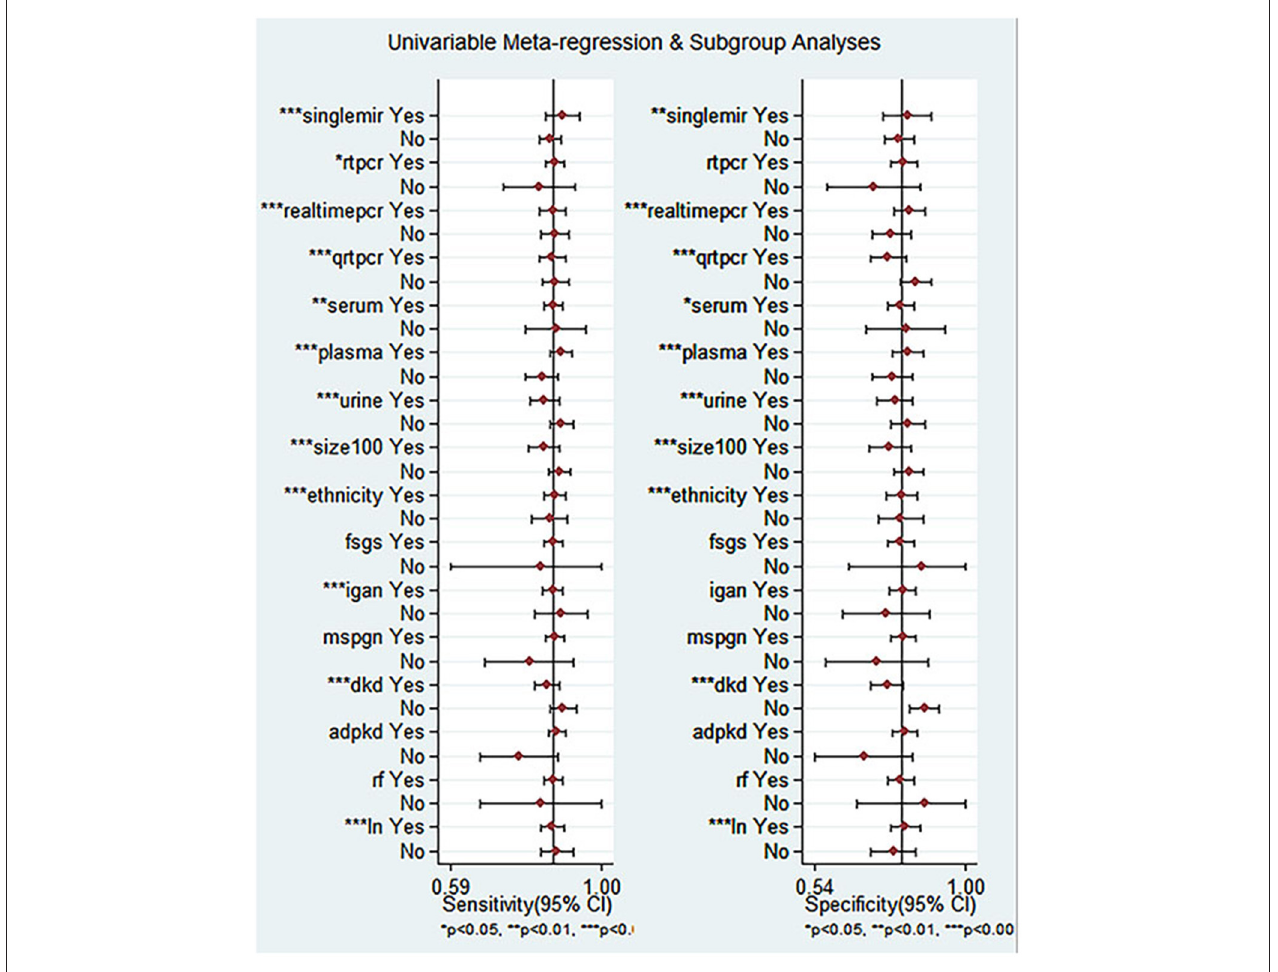
FIGURE 7 | Univariable meta-reqression and subgroup analyses for sensitivity and specificity of miRNA for diagnosis of